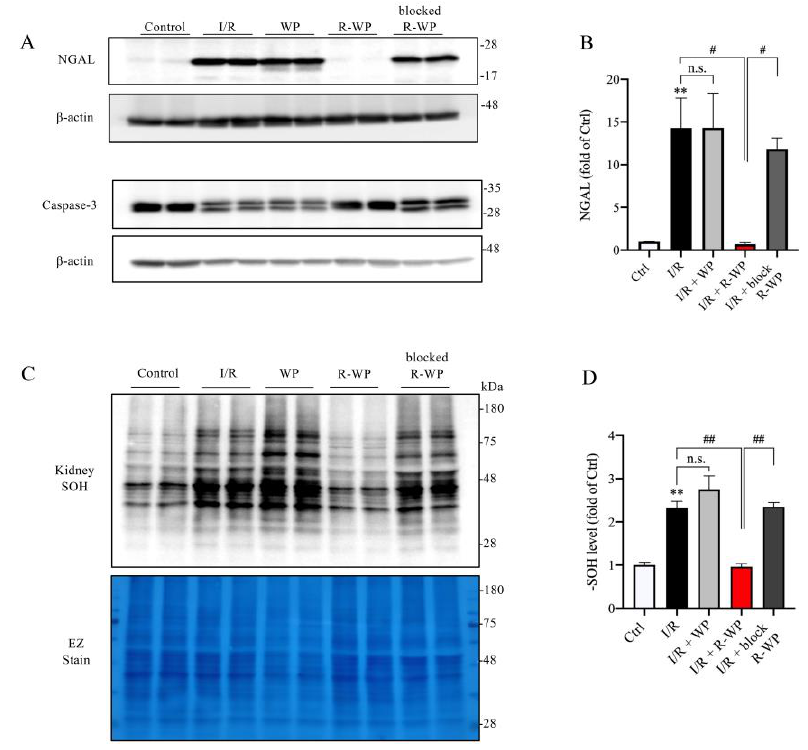
Figure 5. R-WP ameliorates I/R-induced renal cell injury and protein oxidation. ( A , B ) Effect of WP treatment on renal injury markers. Kidney lysates extracted 24 h after I/R were assayed for renal tubular cell injury marker Lipocalin-2 (NGAL) and apoptosis marker caspase-3. Note the obviously increased level of NGAL, as well as the split of caspase-3 in I/R control and its prevention by R-WP. The quantitation of the bands of NGAL is shown in ( B ). Data are expressed at fold change relative to sham control. Data shown are mean ± SE ( n = 4; n.s.: not significant; ** p < 0.01 vs. Ctrl; # p < 0.05 vs. R-WP group). ( C , D ) Effect of WP treatment on -SOH formation. An equal amount of kidney lysate was treated with dimedone and subjected to Western blot analysis for -SOH level. EZ staining of the membrane was used to verify the equal loading of protein in each lane. The densitometric quantification of the signals in ( C ) is shown in bar graph in ( D ). Data shown are mean ± SE ( n = 4;